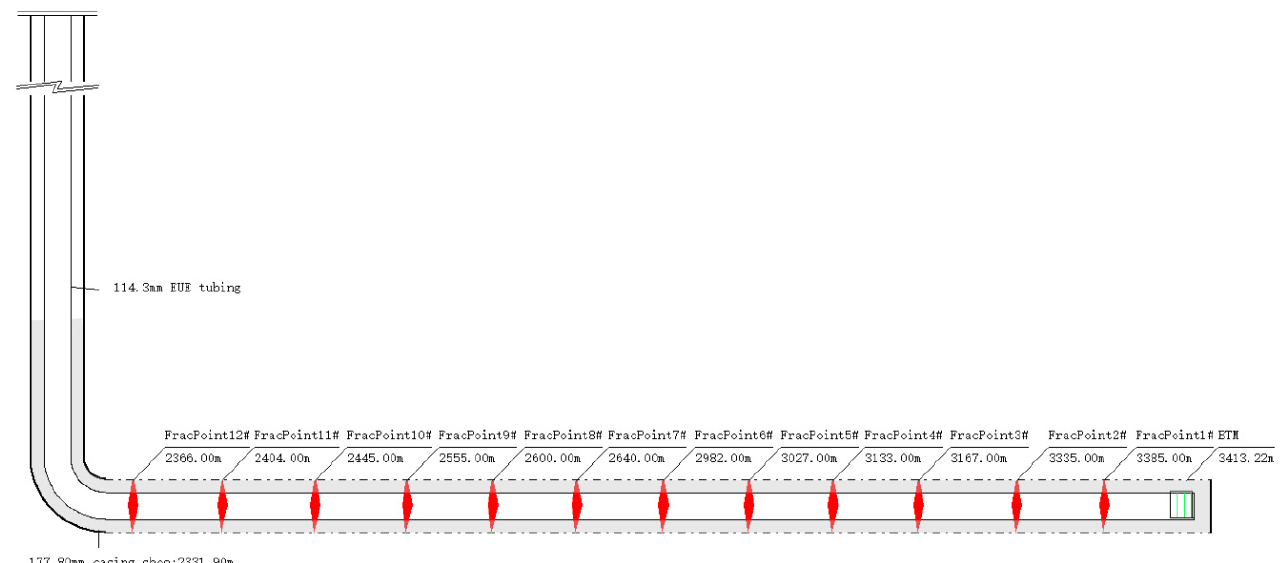
Figure 1. Schematic of coiled tubing with bottom packer hydra-jet multistage fracturing.